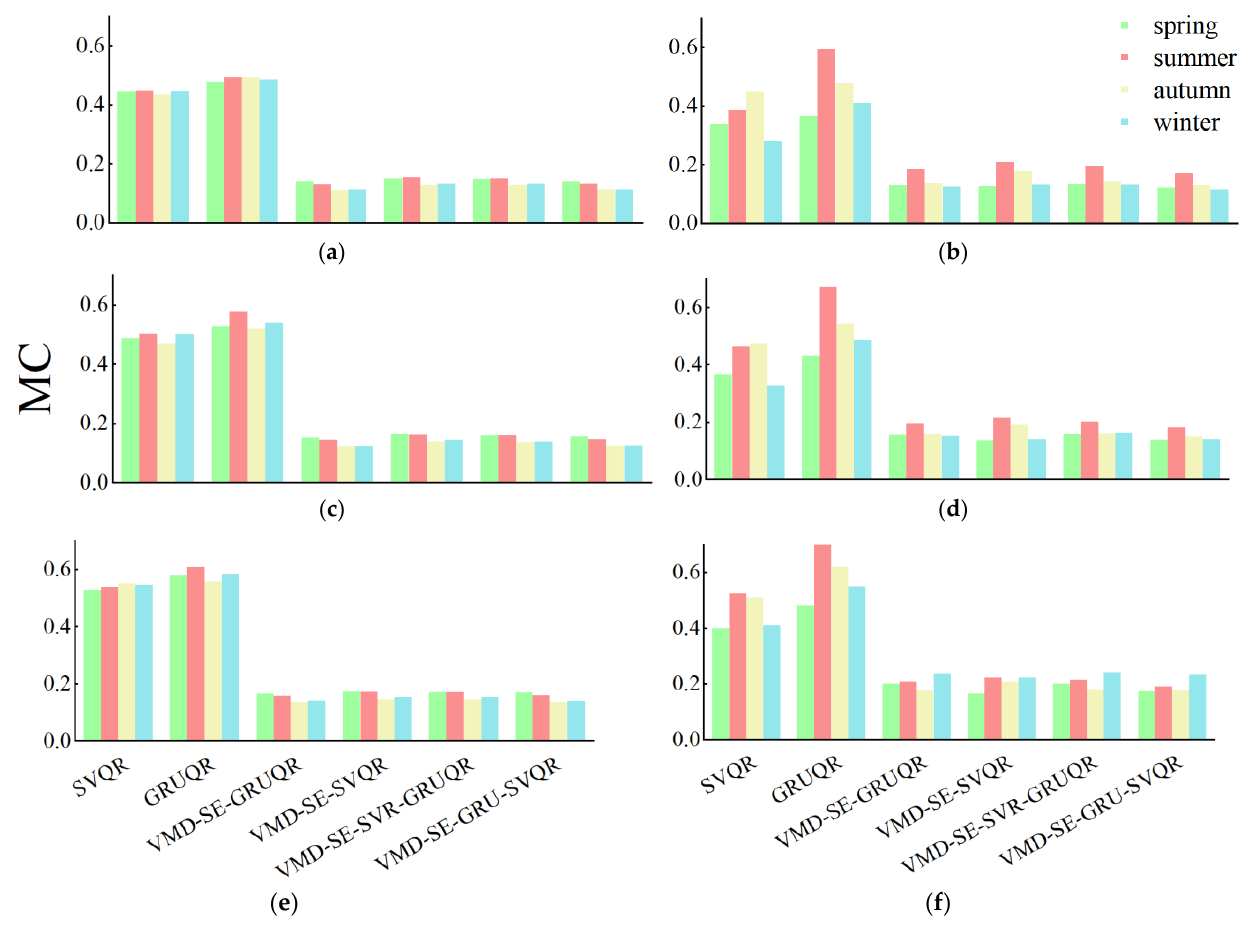
Figure 11. MC values of the model at three confidence levels: ( a ) MC in 80% confidence level of dataset A; ( b ) MC in 80% confidence level of dataset B; ( c ) MC in 85% confidence level of dataset A; ( d ) MC in 85% confidence level of dataset B; ( e ) MC in 90% confidence level of dataset A; ( f ) MC in 90% confidence level of dataset B. Table 8. Averages of the evaluation